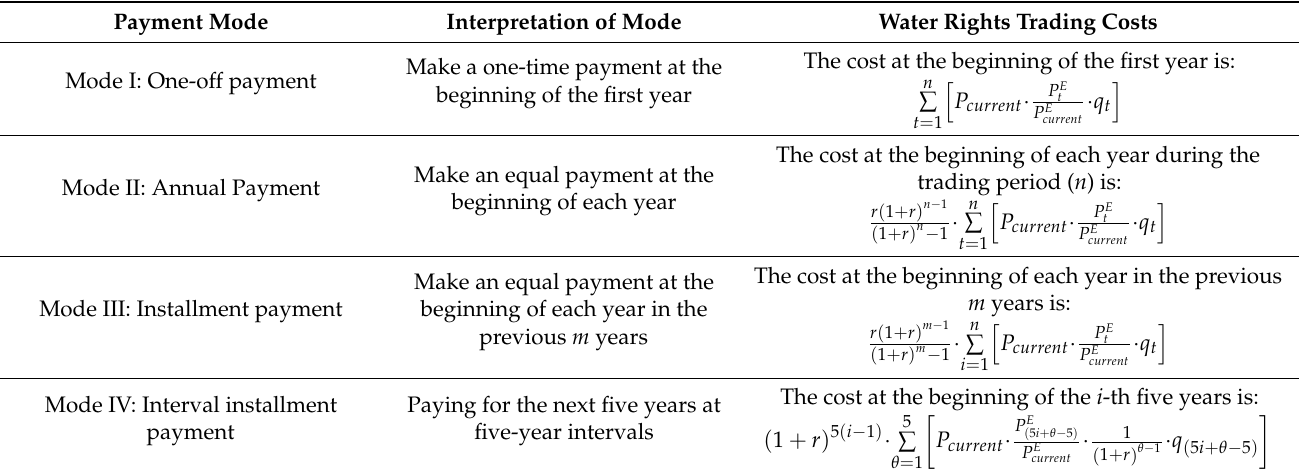
Table 4. Water rights trading costs under different payment